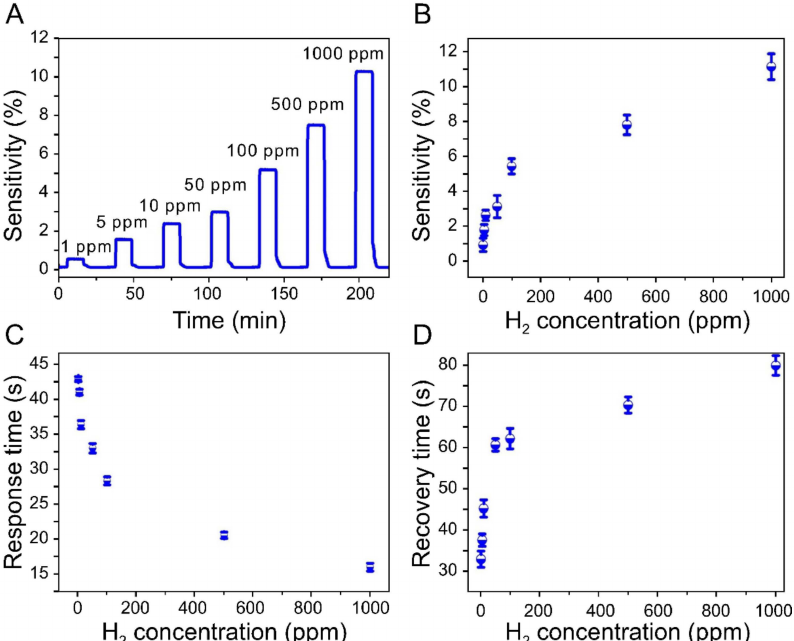
Figure 4. Dynamic response of the sensor to changes in hydrogen concentration. ( A ) Sensitivity results at 1, 5, 10, 50, 100, 500, and 1000 ppm H 2 . ( B ) Comparison of sensitivities at seven di ff erent concentrations. ( C ) Sensor response times at various concentrations of hydrogen. ( D ) Sensor recovery time as a function of hydrogen concentration. The experimental data indicate that the sensor has excellent hydrogen-detection capabilities (detection limit of 1 ppm) with fast response